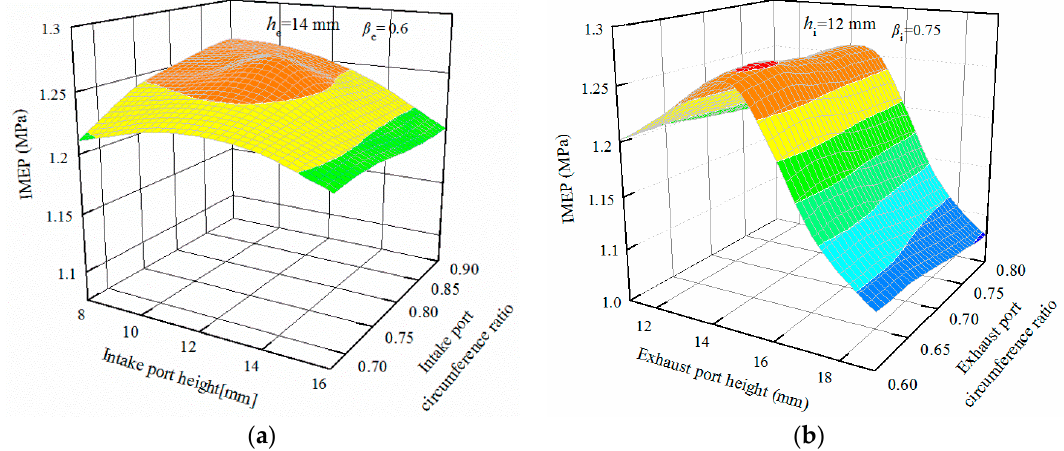
Figure 13. Effect of the port height and circumference ratio on IMEP ( a ) Intake port; ( b ) Exhaust port.